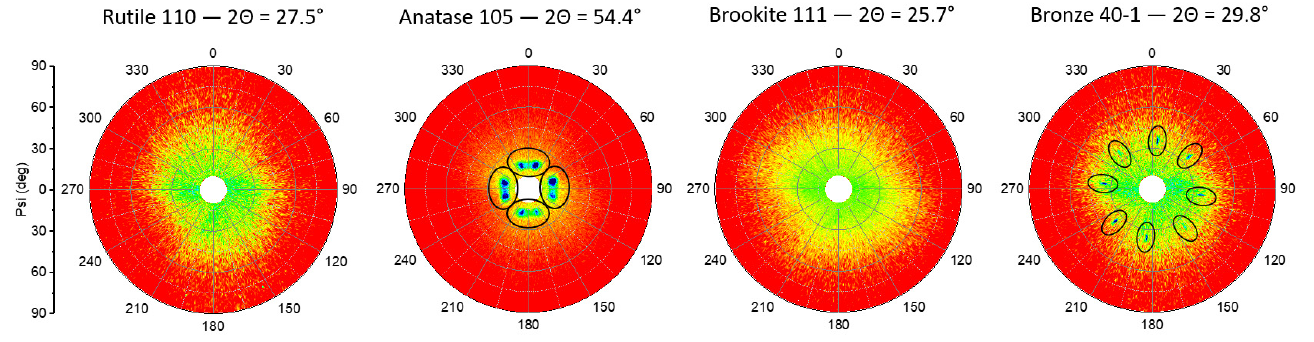
Figure 2. Pole figures around prominent reflections of each of the four main TiO 2 polymorphs con- sidered. The reflections and their corresponding 2theta values are given. Film peaks are highlighted by black